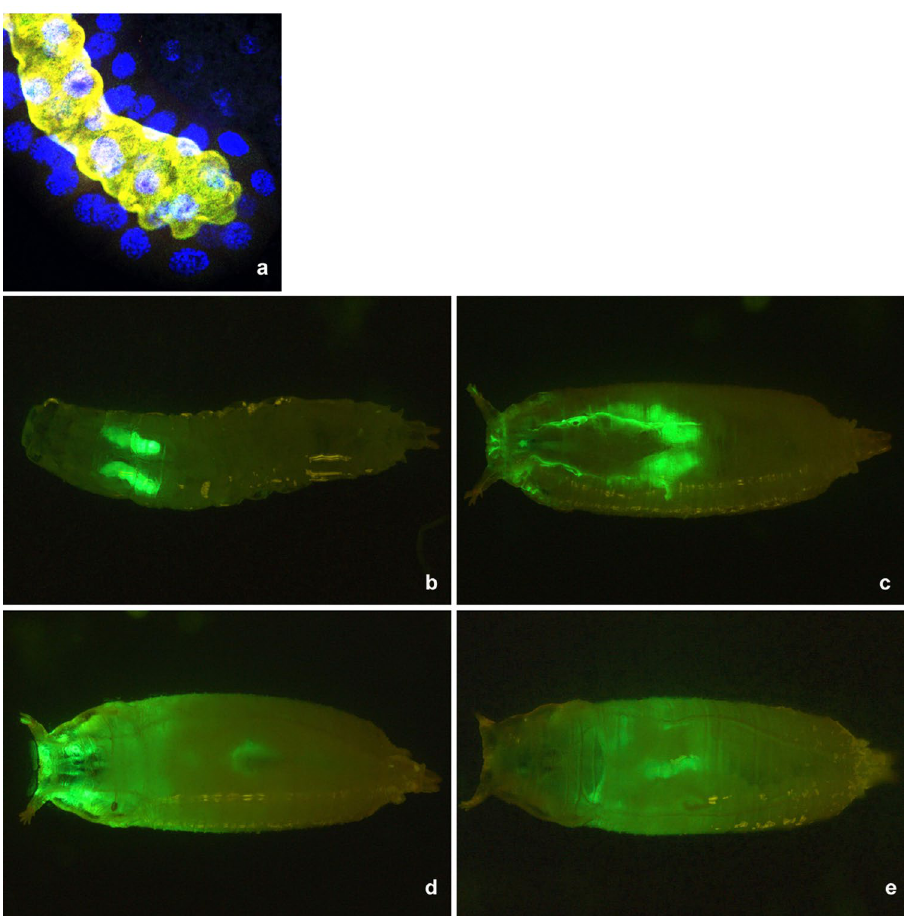
Figure 1. ( a ) Laser confocal view of the prepupal SG from an 8–10 h old wild-type prepupa having an apocrine secretion in its lumen. Visualized are tumor suppressor protein p127 l(2)gl (green), nuclear transcription factor BR–C (red), filamentous actin (dark blue), and DNA (light blue, Hoechst 33,258). The light yellow signal inside the lumen reflects the merging of the three proteinaceous signals. ( b ) Live imaging of late 3rd instar Sgs3 - GFP larva. A strong GFP signal is found exclusively within the secretory granules inside the SGs. ( c ) When all of the Sgs-glue is not released from the SGs during pupariation, GFP signal is released into the SG lumen